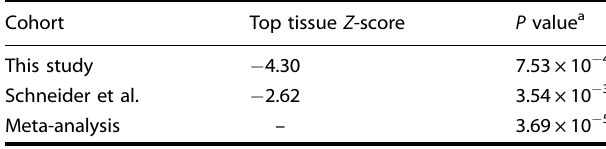
Table 2. Replication and meta-analysis of the GDF5 association. Cohort Top tissue Z -score P value a This study 7.53 × 10 − 4 Schneider et al. a Derived from S-MultiXcan analyses. anthracyclines (i.e. cluster 5) 16 were signi fi cantly enriched in the TWAS data across all tissues after correcting for multiple testing (Table 3 and Supplementary Table 2).